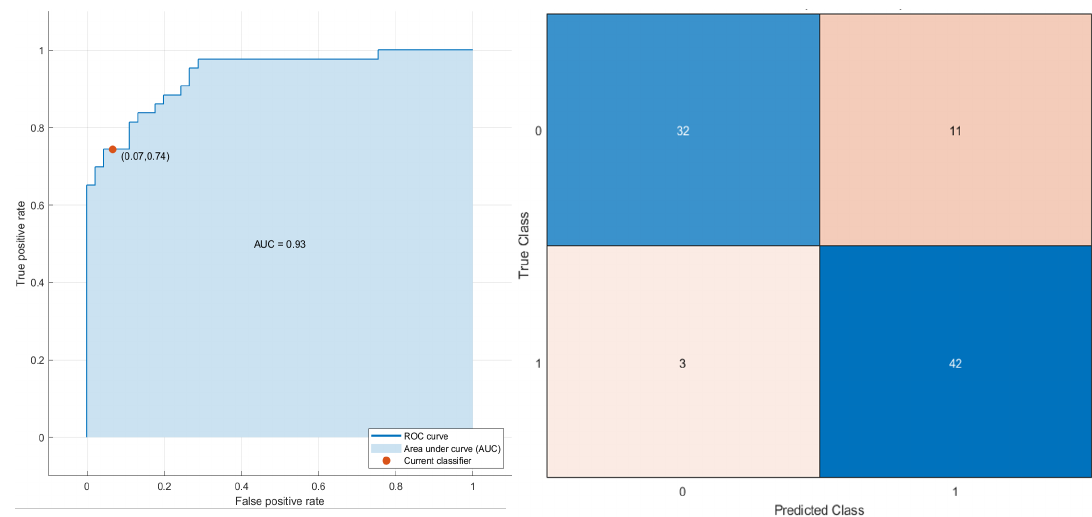
Figure 5. ROC curve and confusion matrix of SVM as the best classifier for stratifying the patients based on OS time (short and long time).